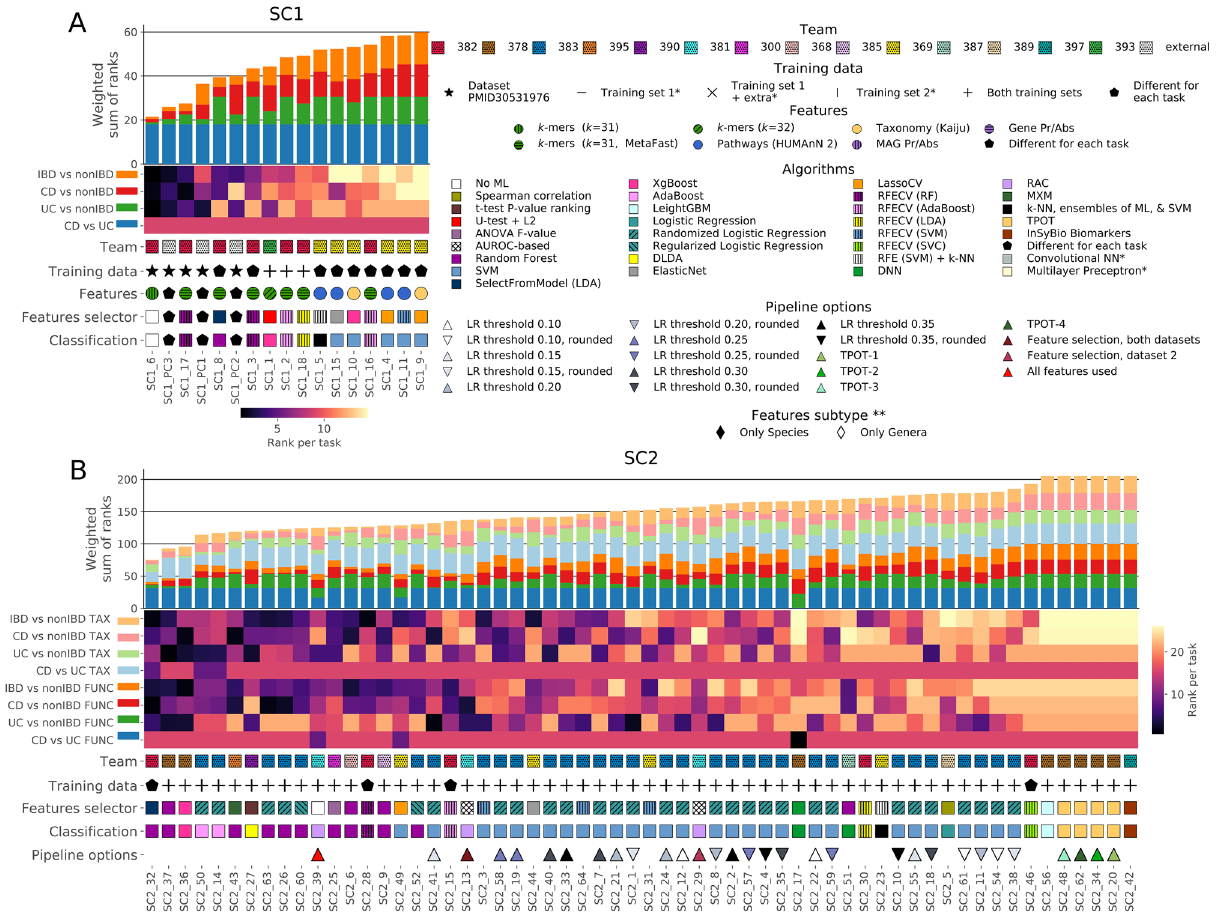
Figure 2. Final submissions ranking in the sbv IMPROVER MEDIC Challenge. Results for SC1(A) and SC2 (B) are shown separately. Bar plot of the weighted sum of ranks (WSR) sorted from the lowest (best) to the highest (worst) WSR. A heatmap shows the WSR stratified by 2-class task and data type (applicable only for SC2 submissions). Submission details such as the submitting team number, feature type (applicable only for SC1 submissions), ML algorithms used for feature selection and classification, and pipeline options are also shown. For optimization purposes, the legend contains additional information not shown on the current summary graphics but required for the interpretation of results in other figures. This and all following figures were generated using Matplotlib python library (version 3.3.3, https:// matpl otlib. Table 1. After the review and acceptance of the scoring results by an independent, external expert panel, the identities of the top three winning teams for each SC were disclosed 14 . Post-challenge analysis. Metagenomics data are informative to discriminate IBD versus nonIBD subjects but insufficient for UC versus CD distinction. The majority of submitted predictions, regardless of the SC, suc- cessfully classified “IBD versus nonIBD” better than random (Table 1, Supplementary Fig. 1), providing signifi- cant (higher than the 95 th percentile of the corresponding null distribution) MCC and/or AUPR values. The number of submissions with MCC and/or AUPR significantly better than random was larger for the “CD versus nonIBD” classification task compared with the “UC versus nonIBD” task. This may be due to a training set imbalance, as there were more CD than UC samples in the training dataset. The discrimination of CD and UC samples within the IBD group was a more challenging task (Table 1). Indeed, none of the SC1 submissions performed significantly better than random. In the case of SC2, three submissions based on Taxonomy and Function data types (not matching among data types) had significant MCCs. Among those, only one submission (based on Function data type) also showed a significant AUPR. Thus, the number of submissions with MCC or AUPR better than 95th percentile of the corresponding null distribution for “CD versus UC” task (3 out of 60) was not higher than in a setting where all submissions were randomly generated. Tree‑based ML approaches along with reference‑free features demonstrated the best overall performance. The scoring results (Fig. 2, more details per-task visualization in Supplementary Fig. 2), combined with the charac- teristics of the participants’ computational approaches used to tackle the challenge, enabled a visualization of key observations made in the scope of the post-challenge analysis regarding effective classification strategies.